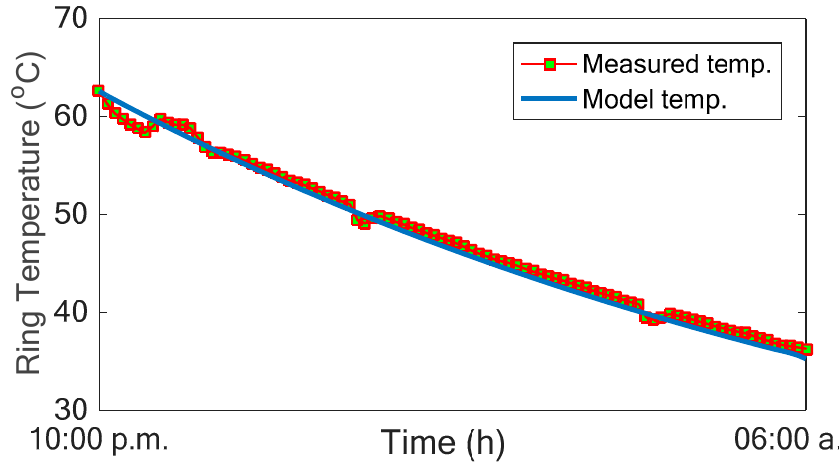
Figure 5. Ring temperature ( V C 0 ) profile: measured data against model results from 10 p.m. to 6 a.m.